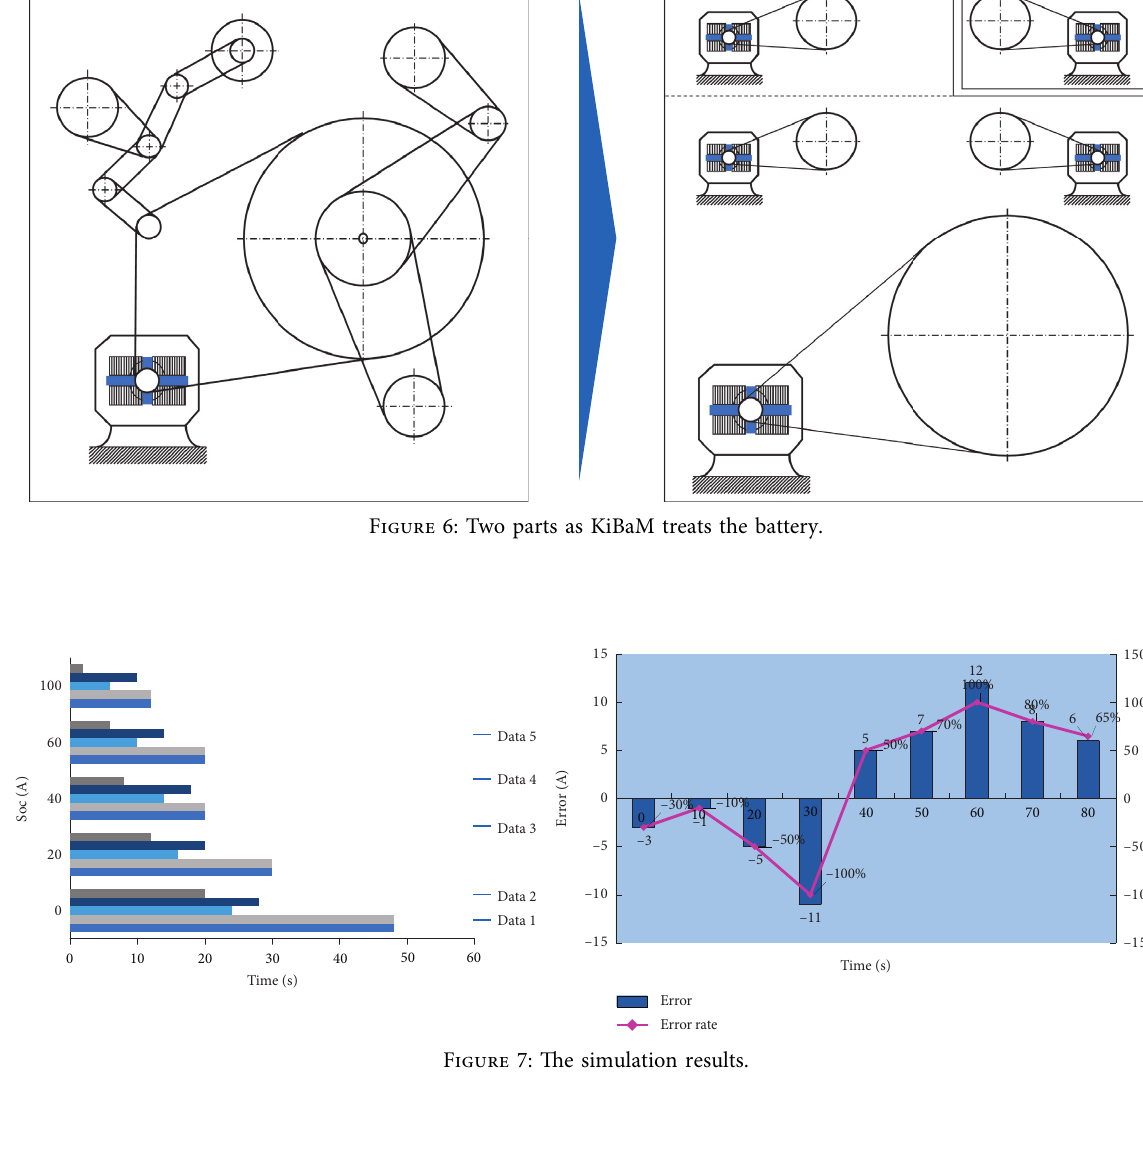
Table 3: The accumulated